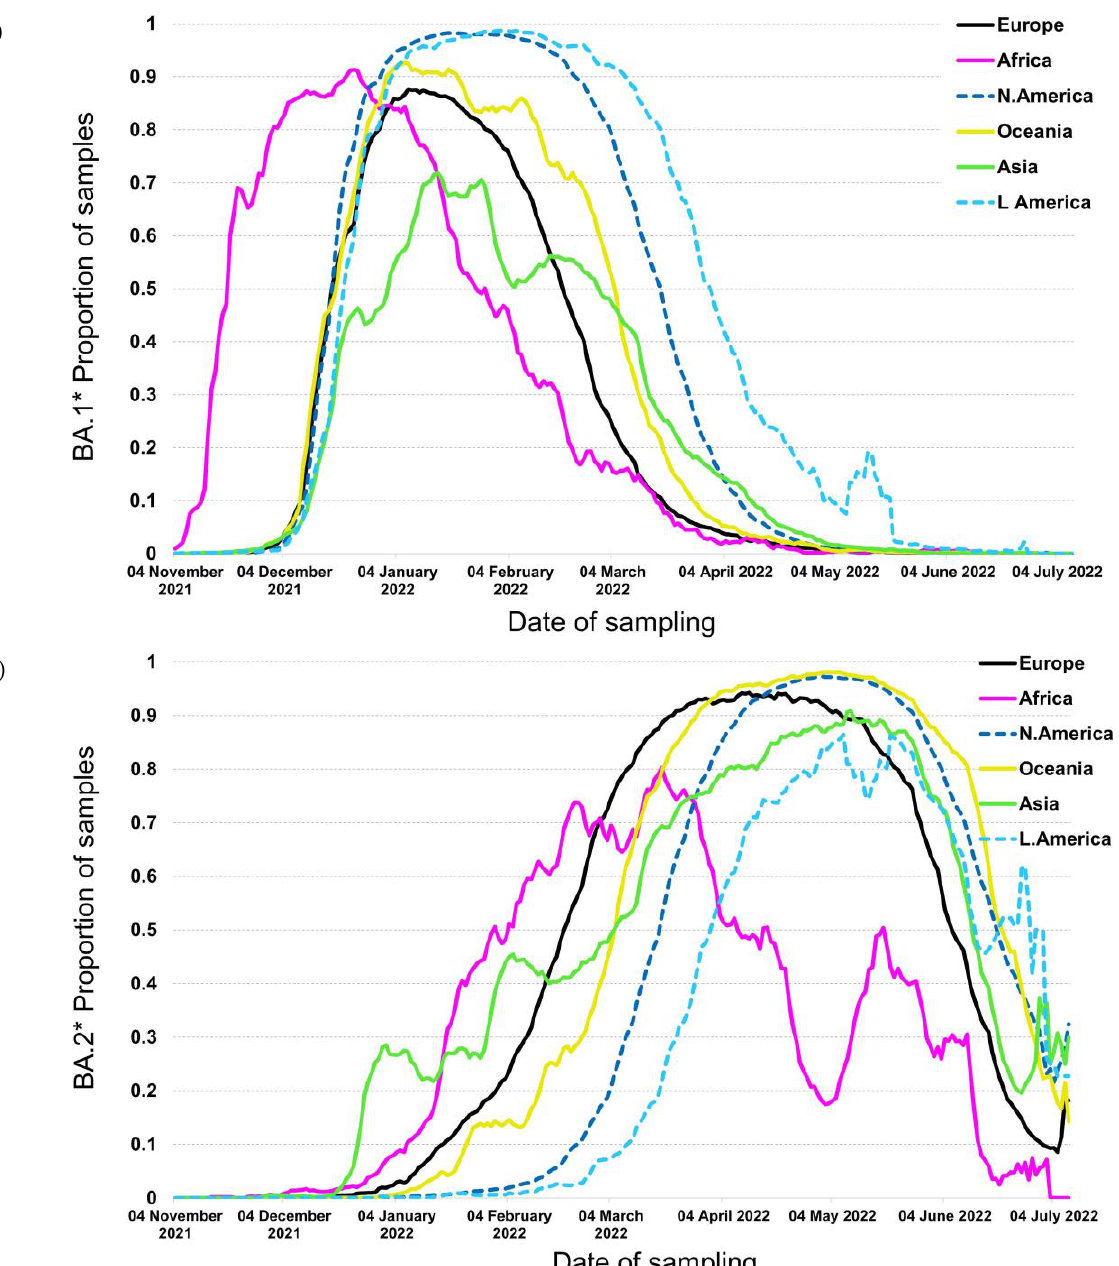
Figure 1. Proportion of samples over time by continent for ( a ) BA.1* and ( b ) BA.2*.